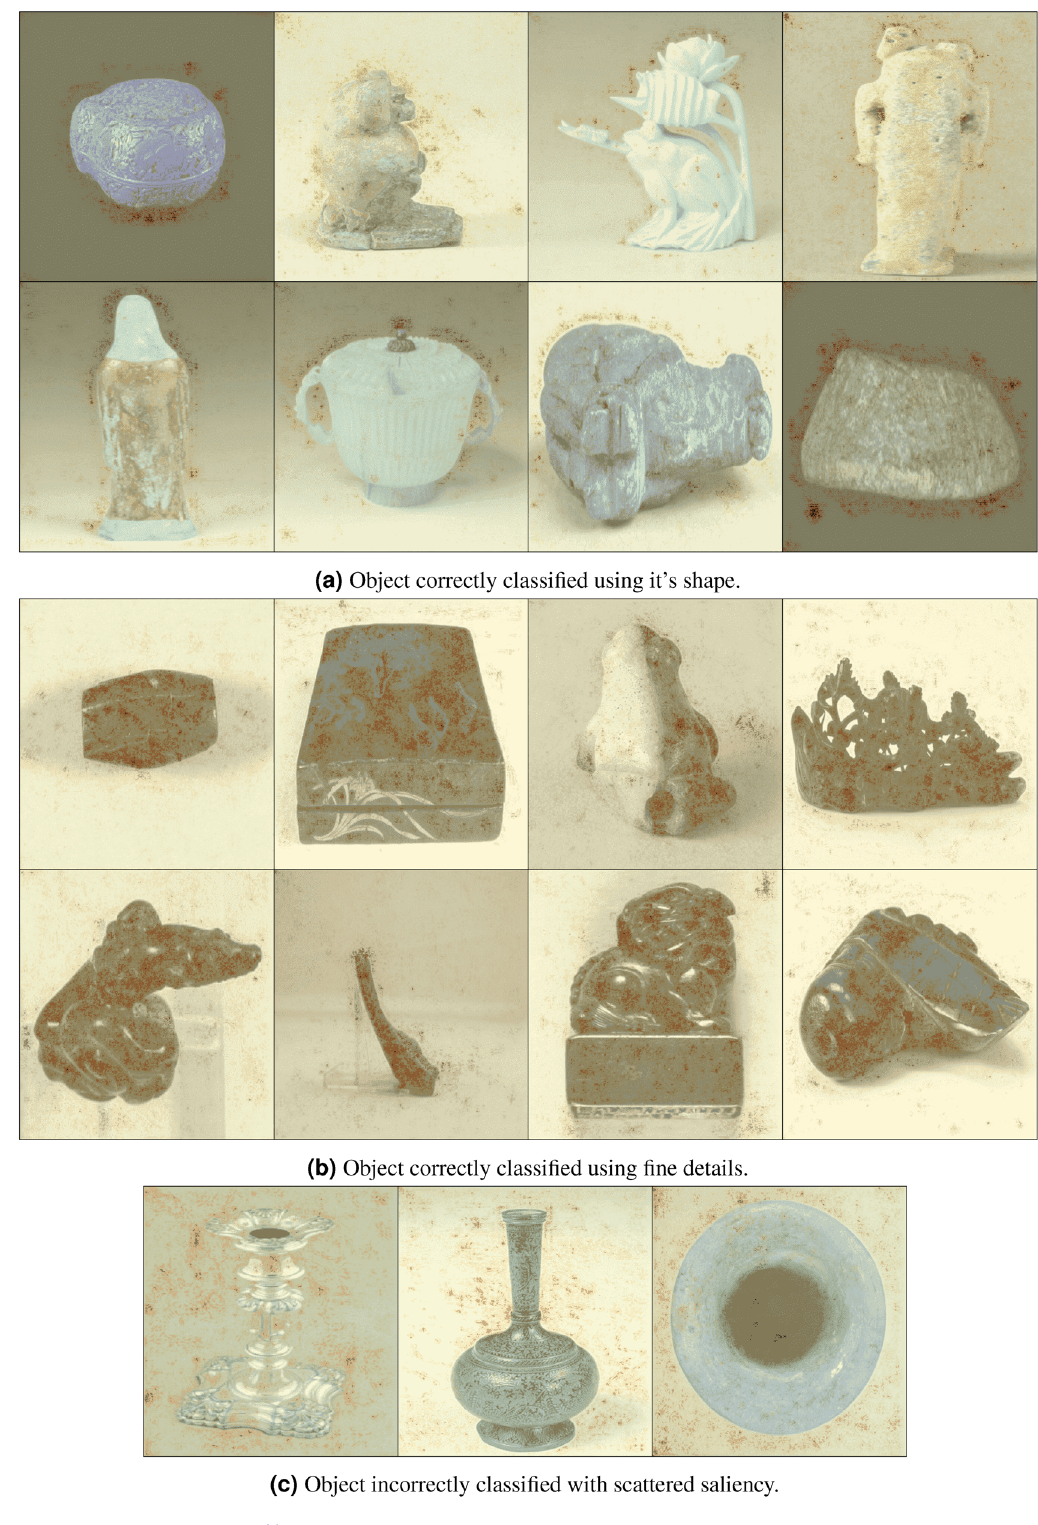
Figure 7. Saliency maps 26 generated from our best model on images-per-instance ≥ 6 (EfficientNet-b6) to visualise which regions in the image are most influential in choosing the instance. The saliency map is overlaid on the original image for clarity. The darker red regions indicate a higher intensity